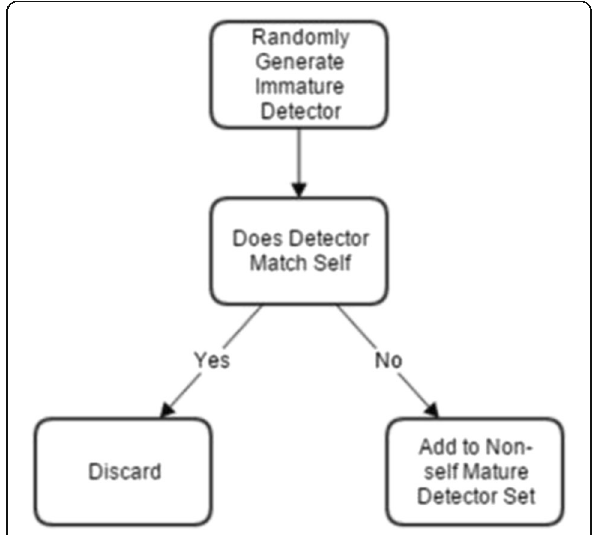
Fig. 1 Non-self detector set